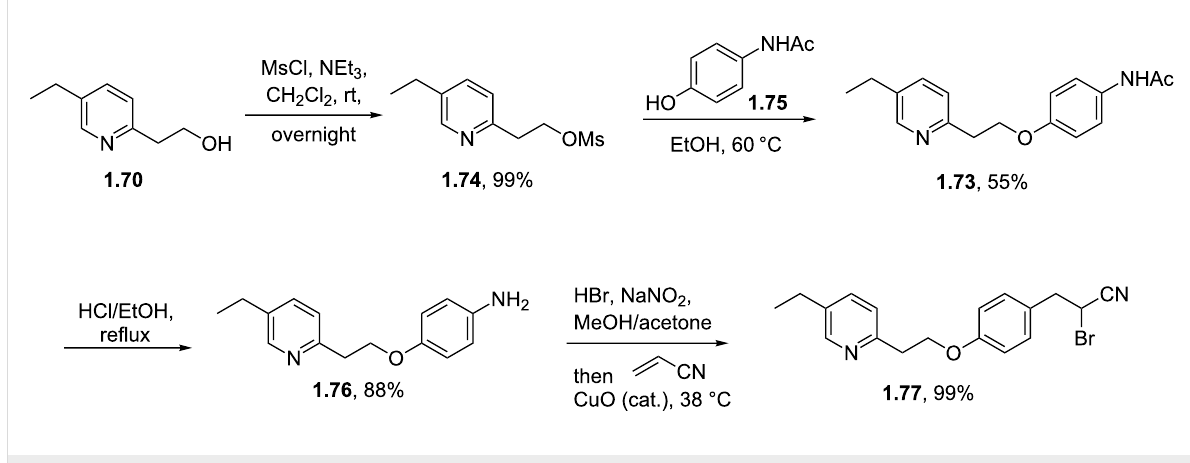
Scheme 13: Meerwein arylation reaction towards pioglitazone.